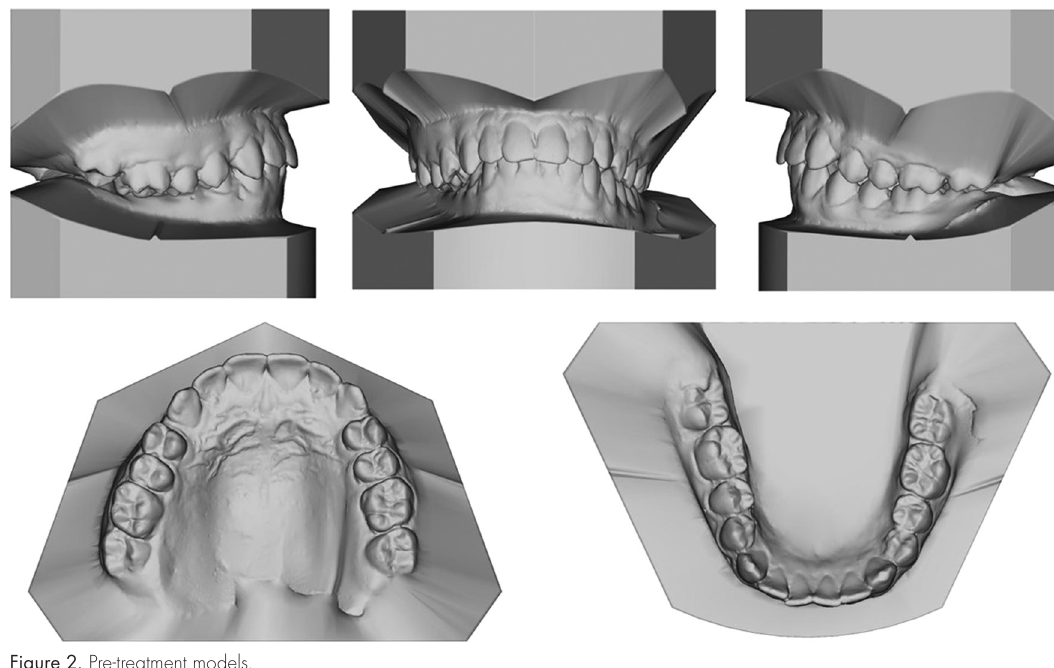
Figure 2. Pre-treatment models.